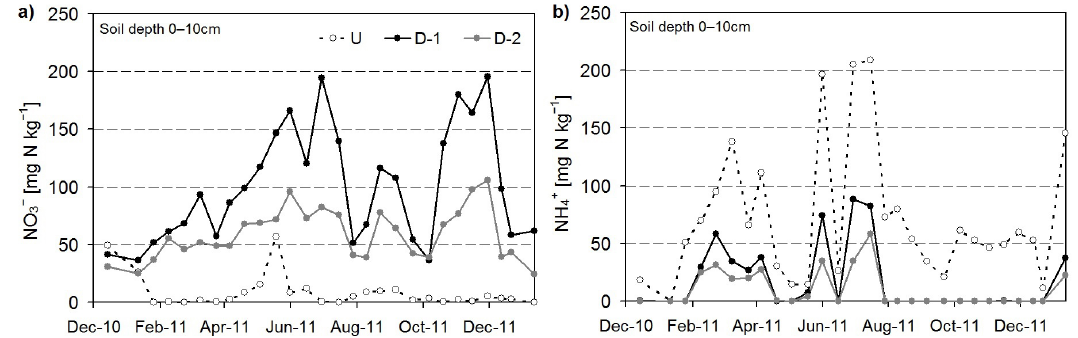
Figure 2. Annual variation in the extractable NO −